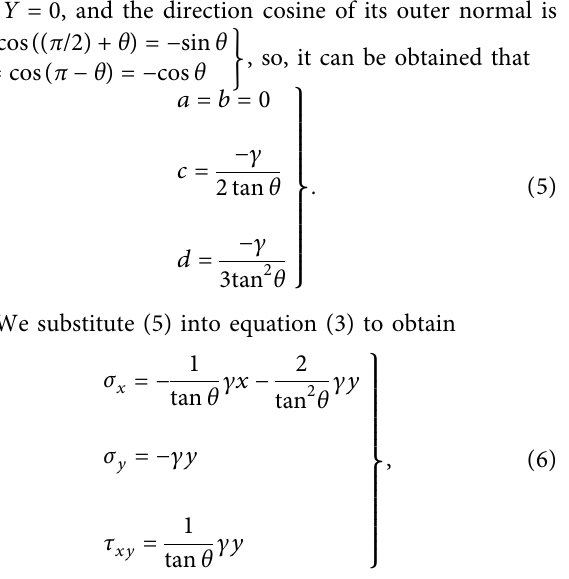
Figure 5: Maximum strain